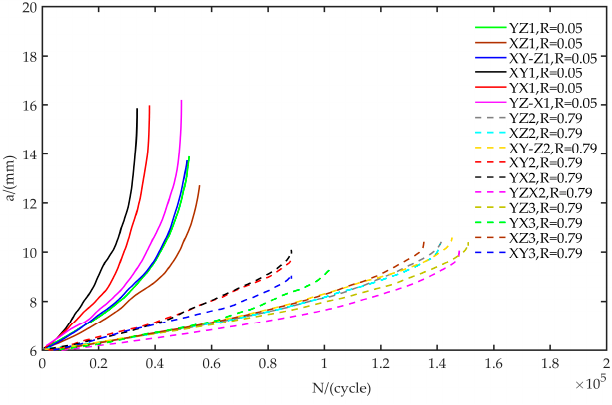
Figure 5. The a-N results of fatigue crack growth tests.